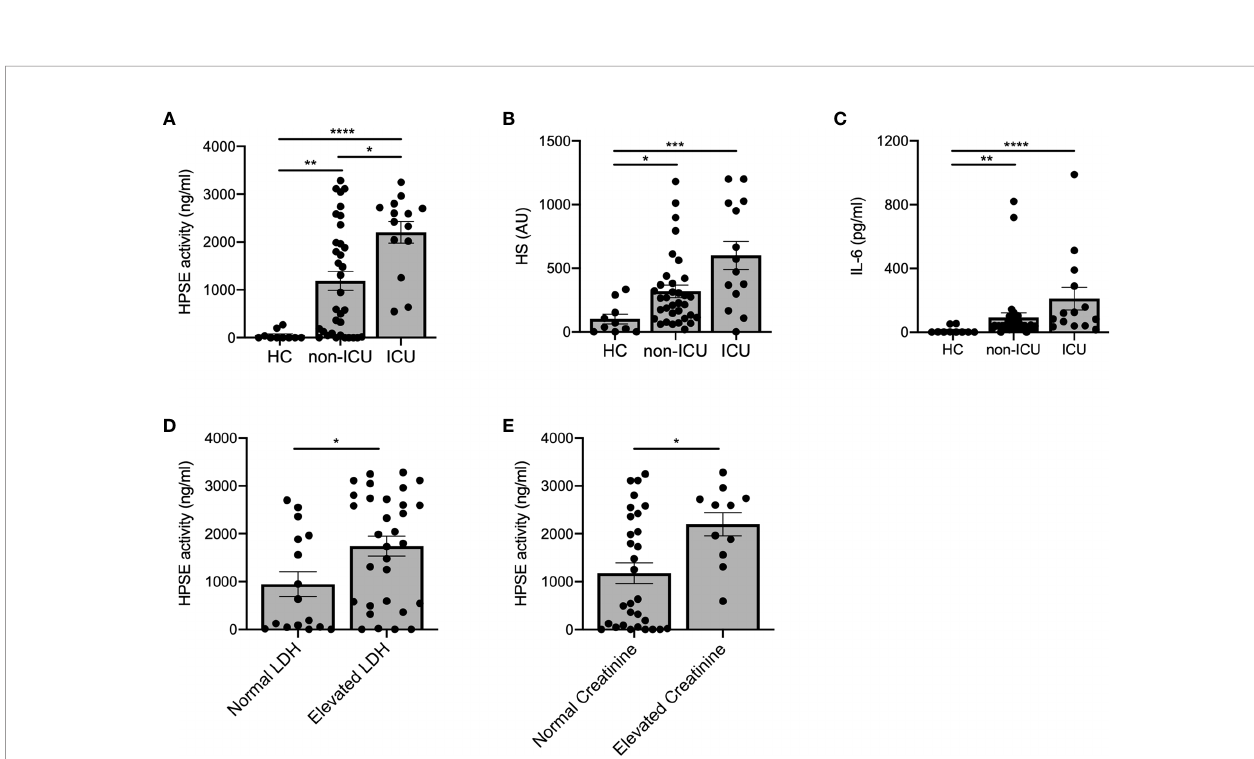
FIGURE 2 | Increased plasma HPSE activity associates with COVID-19 disease severity. (A) Plasma HPSE activity was signi fi cantly higher in ICU and non-ICU patients compared to healthy controls, and higher in ICU patients compared to non-ICU patients (n = 10 healthy; n = 34 non-ICU; n = 14 ICU). (B) HS plasma levels were signi fi cantly increased in plasma of ICU and non-ICU patients compared to healthy controls (n = 10 healthy; n = 34 non-ICU; n = 14 ICU). (C) IL-6 plasma levels were signi fi cantly increased in plasma of ICU and non-ICU patients compared to healthy controls (n = 10 healthy; n = 34 non-ICU; n = 14 ICU). (D) HPSE activity was signi fi cantly higher in plasma of patients with elevated LDH (>280 U/L) values compared to patients with normal LDH levels (n = 15 normal LDH; n = 26 elevated LDH). (E) HPSE activity was signi fi cantly higher in plasma of patients with elevated creatinine (>110 µmol/L for men and >90 µmol/L for women) values compared to patients with normal creatinine values (n = 30 normal creatinine; n = 11 elevated creatinine; patients with history of renal disease were excluded from this analysis). HPSE activity was measured using an in-house developed ELISA with a speci fi c anti-HS antibody and HS plasma levels were measured using an in- house developed competition ELISA with a speci fi c anti-HS antibody. Data were presented as mean ± SEM and tested for normal distribution with D ’ Agostino & Pearson omnibus normality test and statistical differences were calculated using Kruskal Wallis test followed by Dunn ’ s multiple comparison test, unpaired one-tailed Student ’ s t-test or unpaired one-tailed Mann Whitney test (*p < 0.05; **p < 0.01; ***p < 0.001; ****p < 0.0001). HPSE, heparanase; HS, heparan sulfate; LDH, lactate dehydrogenase; Healthy, healthy controls; non-ICU, COVID-19 patients in normal hospital ward; ICU, COVID-19 patients in ICU; AU, arbitrary